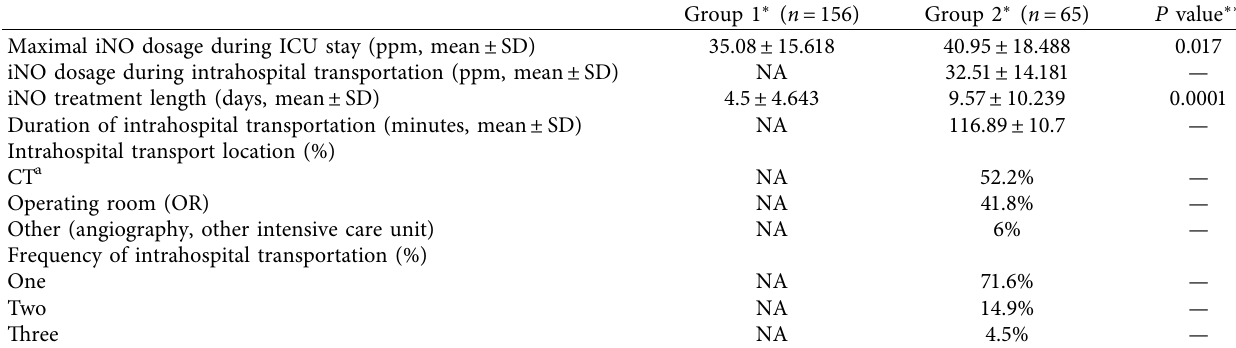
Table 2: iNO treatment data and intrahospital patient transportation (Group (2)) data during the ICU stay.